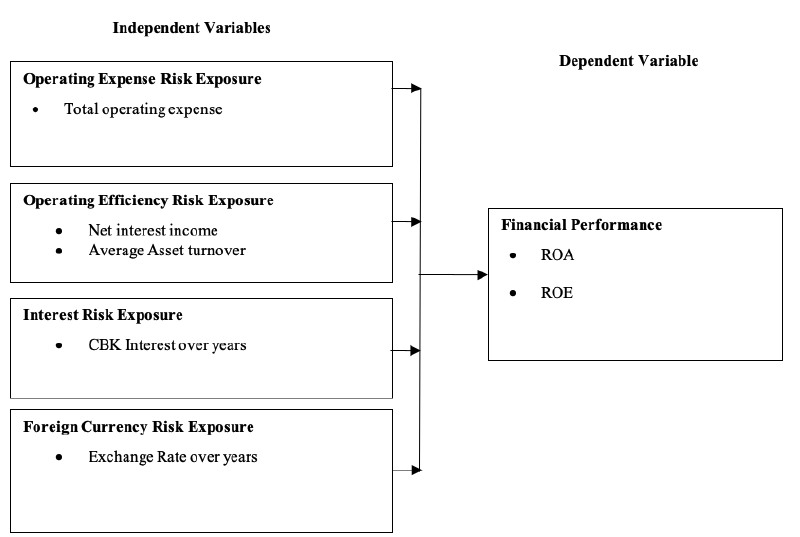
Figure 1: Conceptual